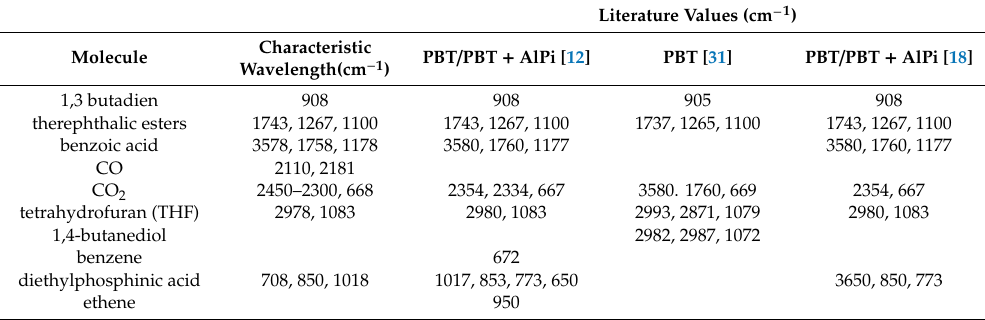
Table 4. Overview of the characteristic molecules identified vs. literature values.